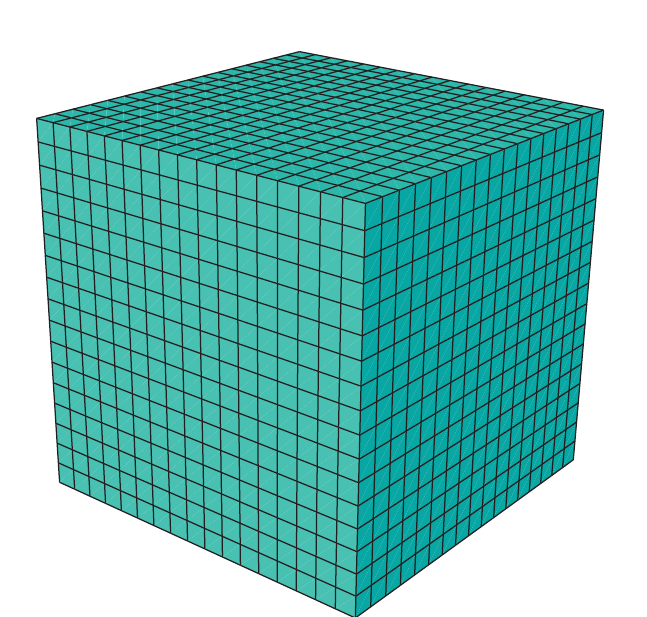
Figure 2: FEA model of Model 1.